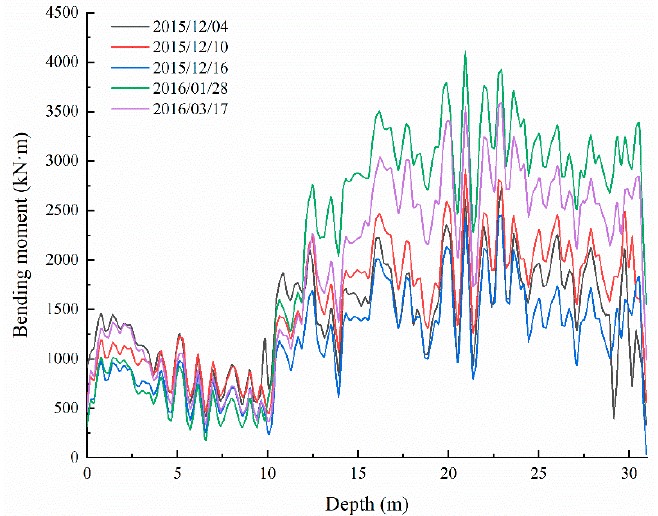
Figure 10. Second stage graph of bending moment development of the anti-slide pile.